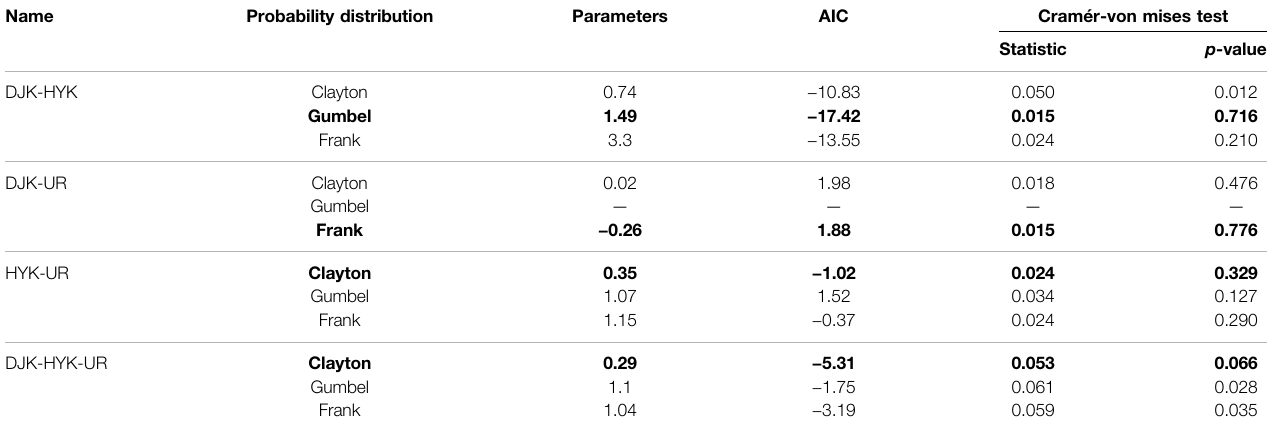
TABLE 5 | Parameter estimation and goodness-of- fi t testing of copulas. Name